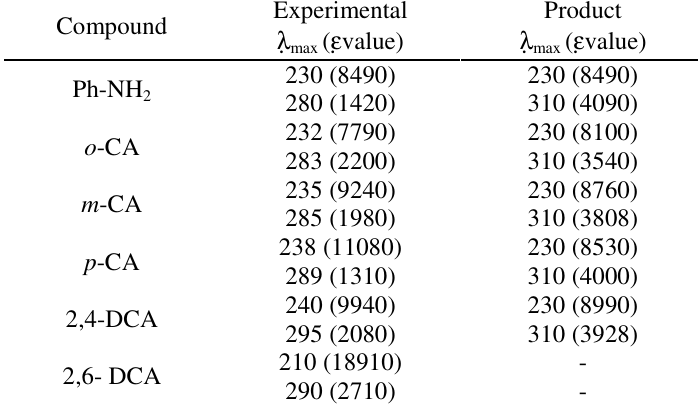
and molar absorptivity ( ε ) of aniline and chloroanilines max